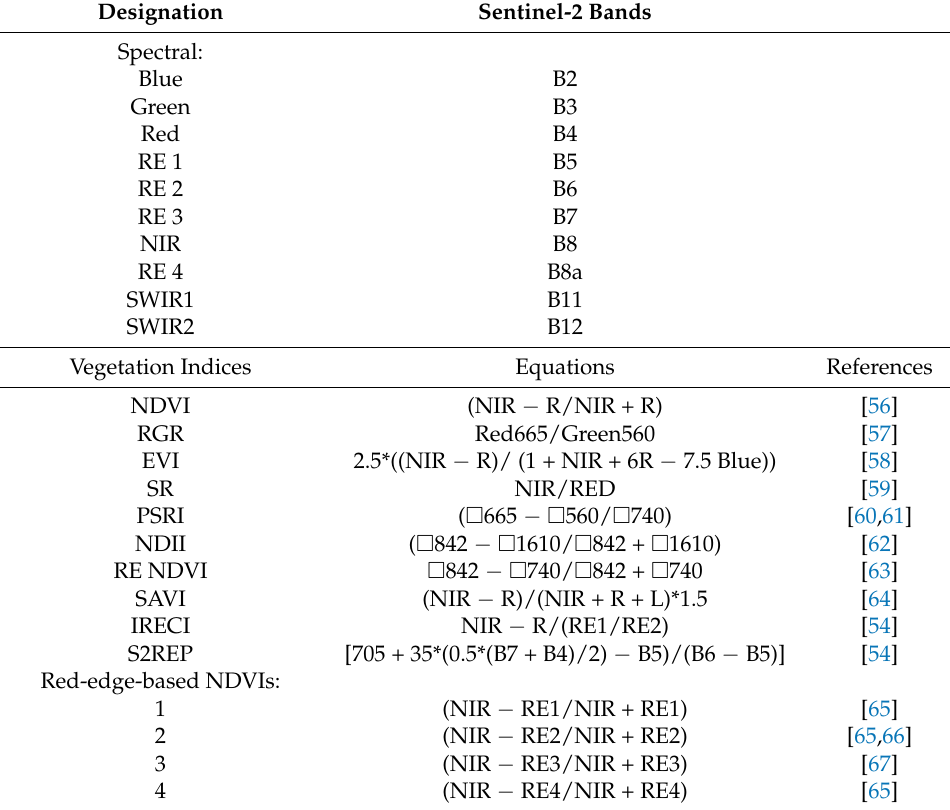
Table 1. Spectral and vegetation indices calculated from Sentinel-2 used in this